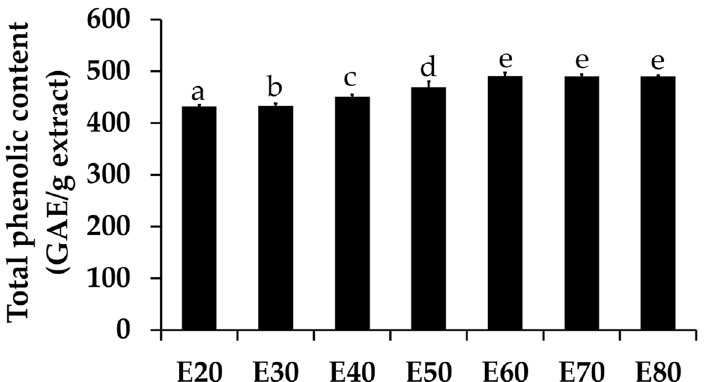
Figure 2. Total phenolic concentrations of Sripanya pomegranate peel extracts. E20, E30, E40, E50, E60, E70, and E80 were Sripanya pomegranate peel extracts obtained by maceration in 20%, 30%, 40%, 50%, 60%, 70%, and 80% v/v of ethanol. Different letters denote statistically significant differences among groups; p < 0.05.